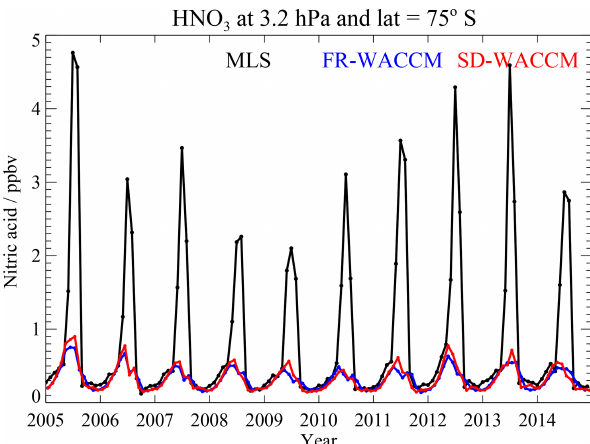
Figure 13. HNO 3 monthly zonal mean mixing ratio time series (2005 through 2014) from MLS, FR-WACCM, and SD-WACCM for 3.2hPa and 70–80 ◦